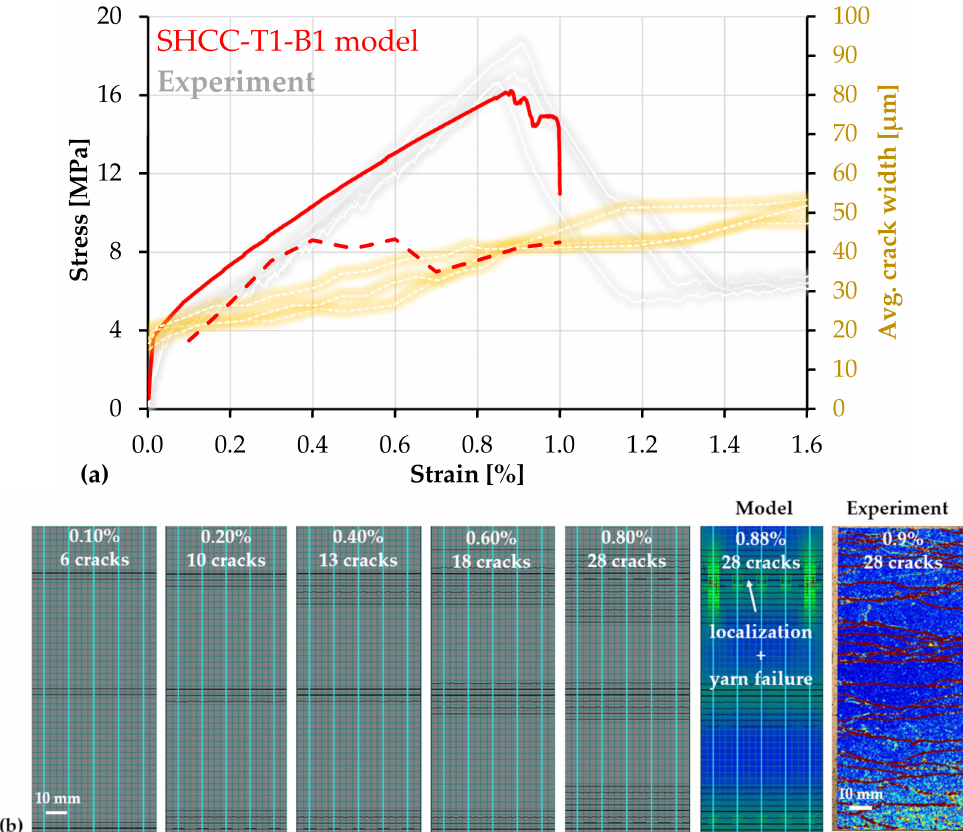
Figure 14. ( a ) Macroscopic stress–strain curve (continuous) and average crack widths (dashed) of SHCC-T1-B1 model composite with experimental results adopted from [13]; ( b ) crack pattern and sequence in the loaded model including the principal stresses in SHCC at yarn failure and a representative experimental crack pattern based on DIC